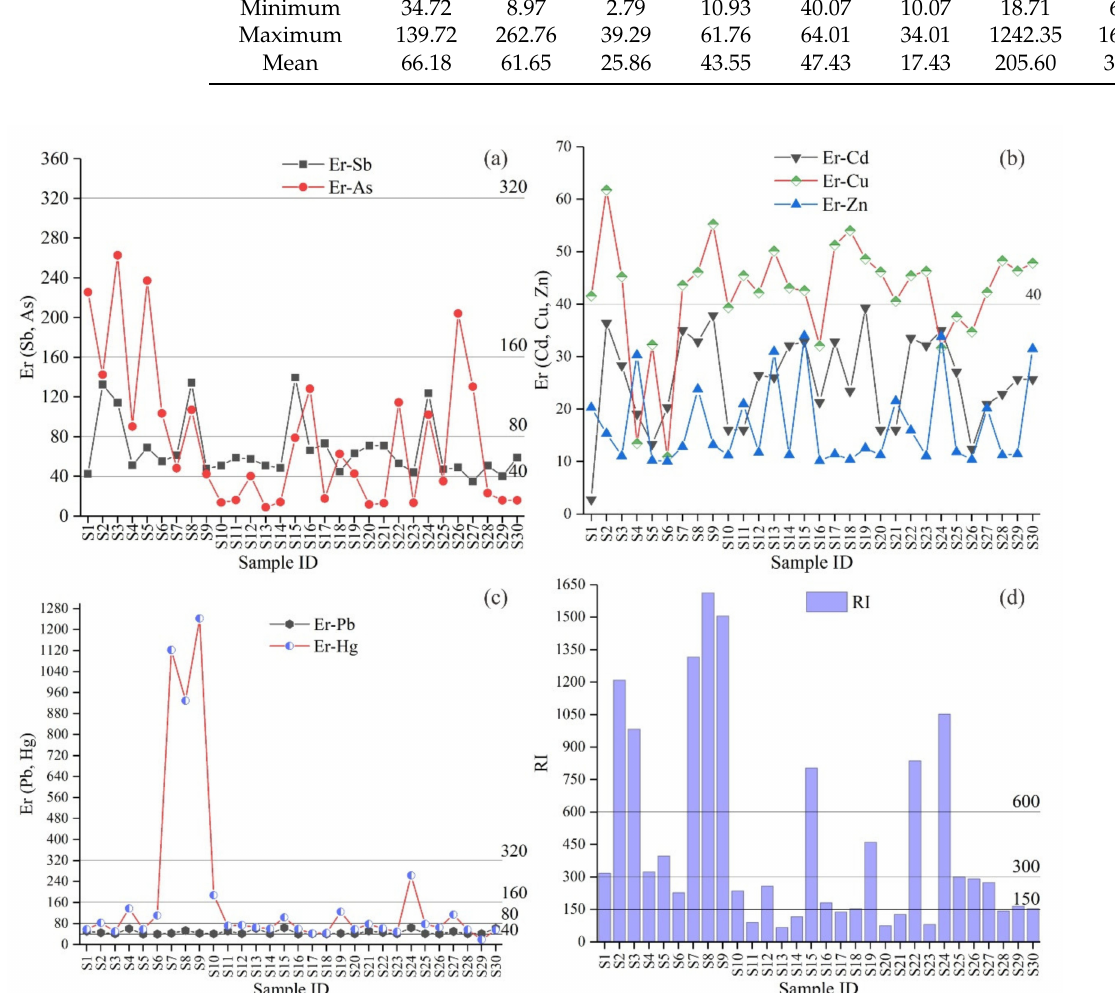
Figure 7. ( a – c ). Ecological risk (Er) and ( d ) Risk Index (RI) values of the PTEs in the study